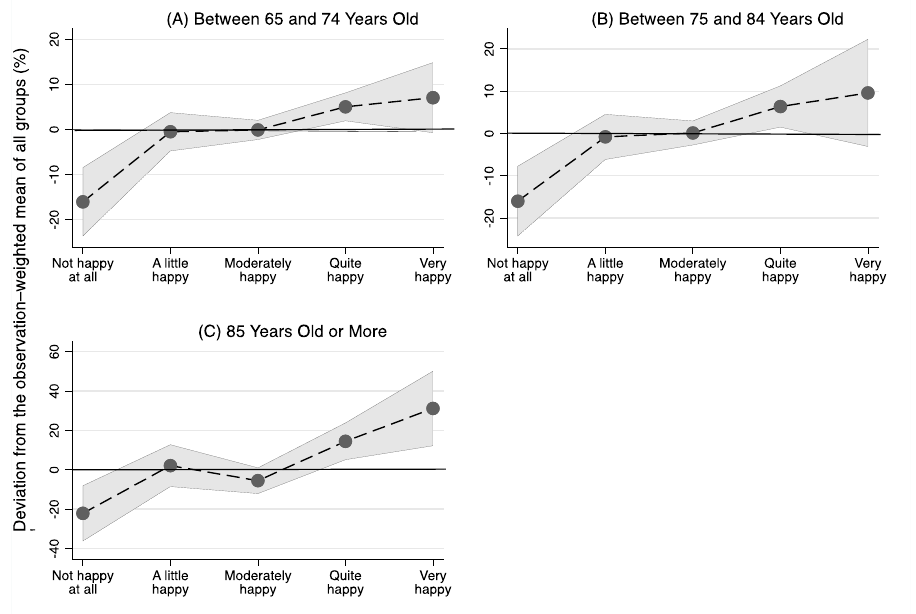
Figure 1. Contrasts of linear predictions of happiness categories with 95% confidence intervals. Note: The line at zero indicates the observation-weighted mean of all groups.